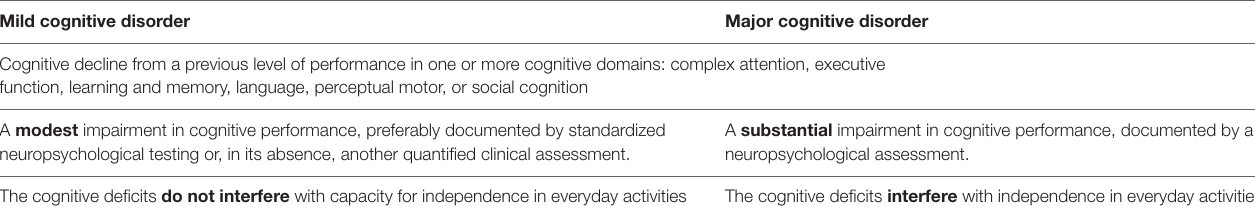
TABLE 1 | Clinical criteria for mild and/or major cognitive disorder diagnosis (American Psychiatric Association [APA], 2013). Mild cognitive disorder Major cognitive disorder